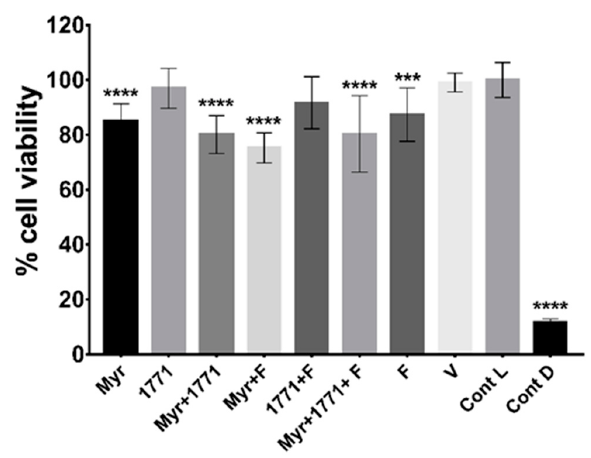
Figure 11. Cell viability of keratinocytes NOK-si after exposure to treatments. The data represented are the means, and the error bars correspond to the standard deviation “Cont L” indicates cell viability control and “Cont D”, the cell death control. The percentage of cell viability was obtained considering the cell viability control as 100%. The asterisks denote a statistically significant difference of a specific extract versus cell viability control (Cont L), where **** p < 0.0001 and *** p = 0.0005 (one-way ANOVA, followed by Tukey’s test).